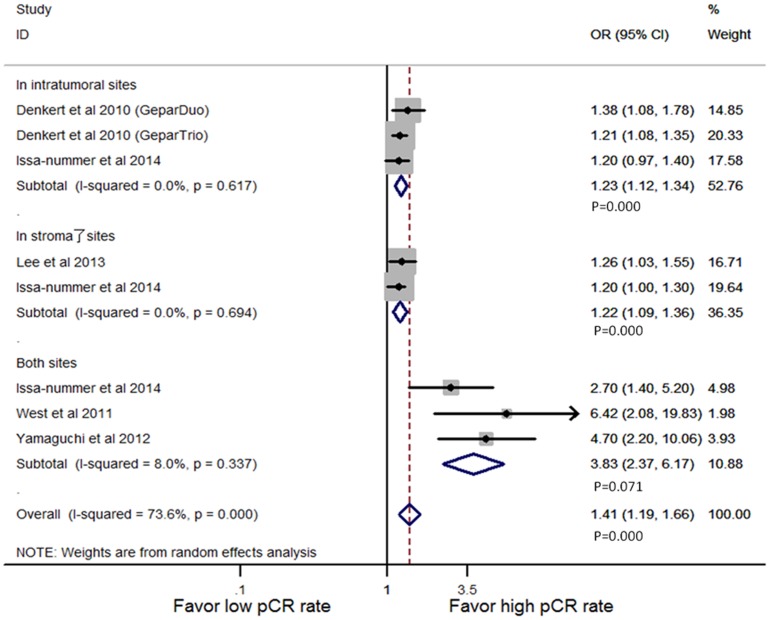
Forest plots from the random-effect meta-analysis of the efficacy of TILs on the NAC response stratified by infiltration locations in multivariate way.The width of horizontal line represents 95% CI of the individual studies, and the grey boxes represent the weight of each study. The diamond represents the overall summary estimate. The unbroken vertical line was set at the null value (HR = 1.0).